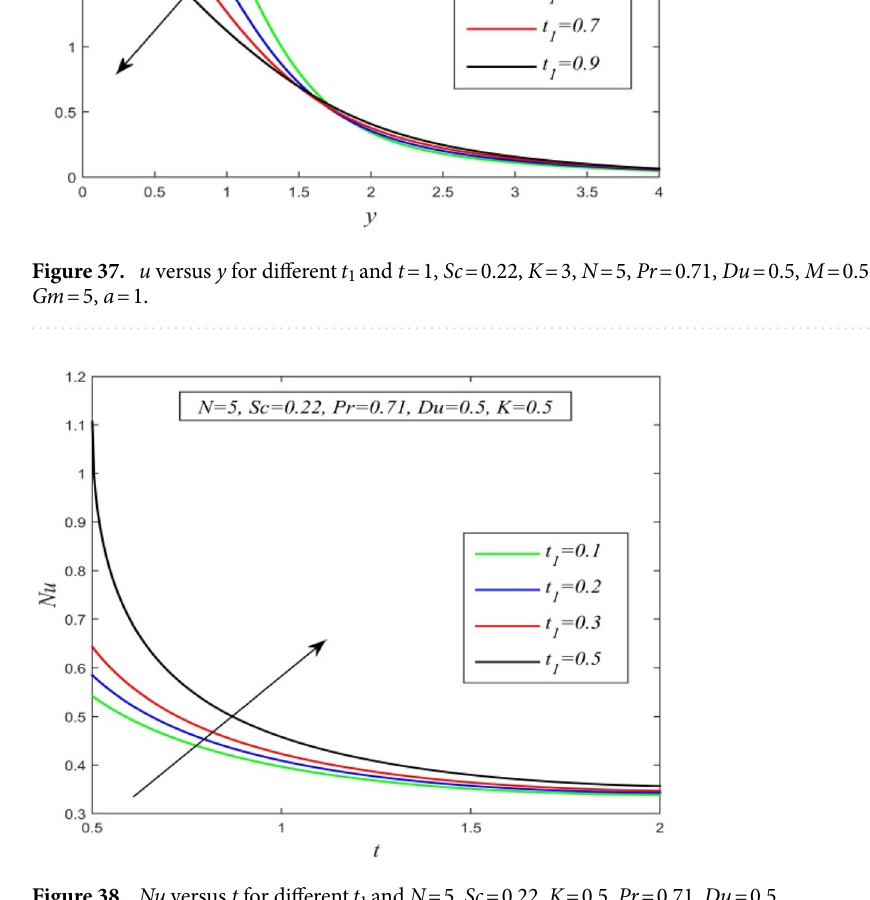
Figure 38. Nu versus t for different t 1 and N = 5, Sc = 0.22, K = 0.5, Pr = 0.71, Du =